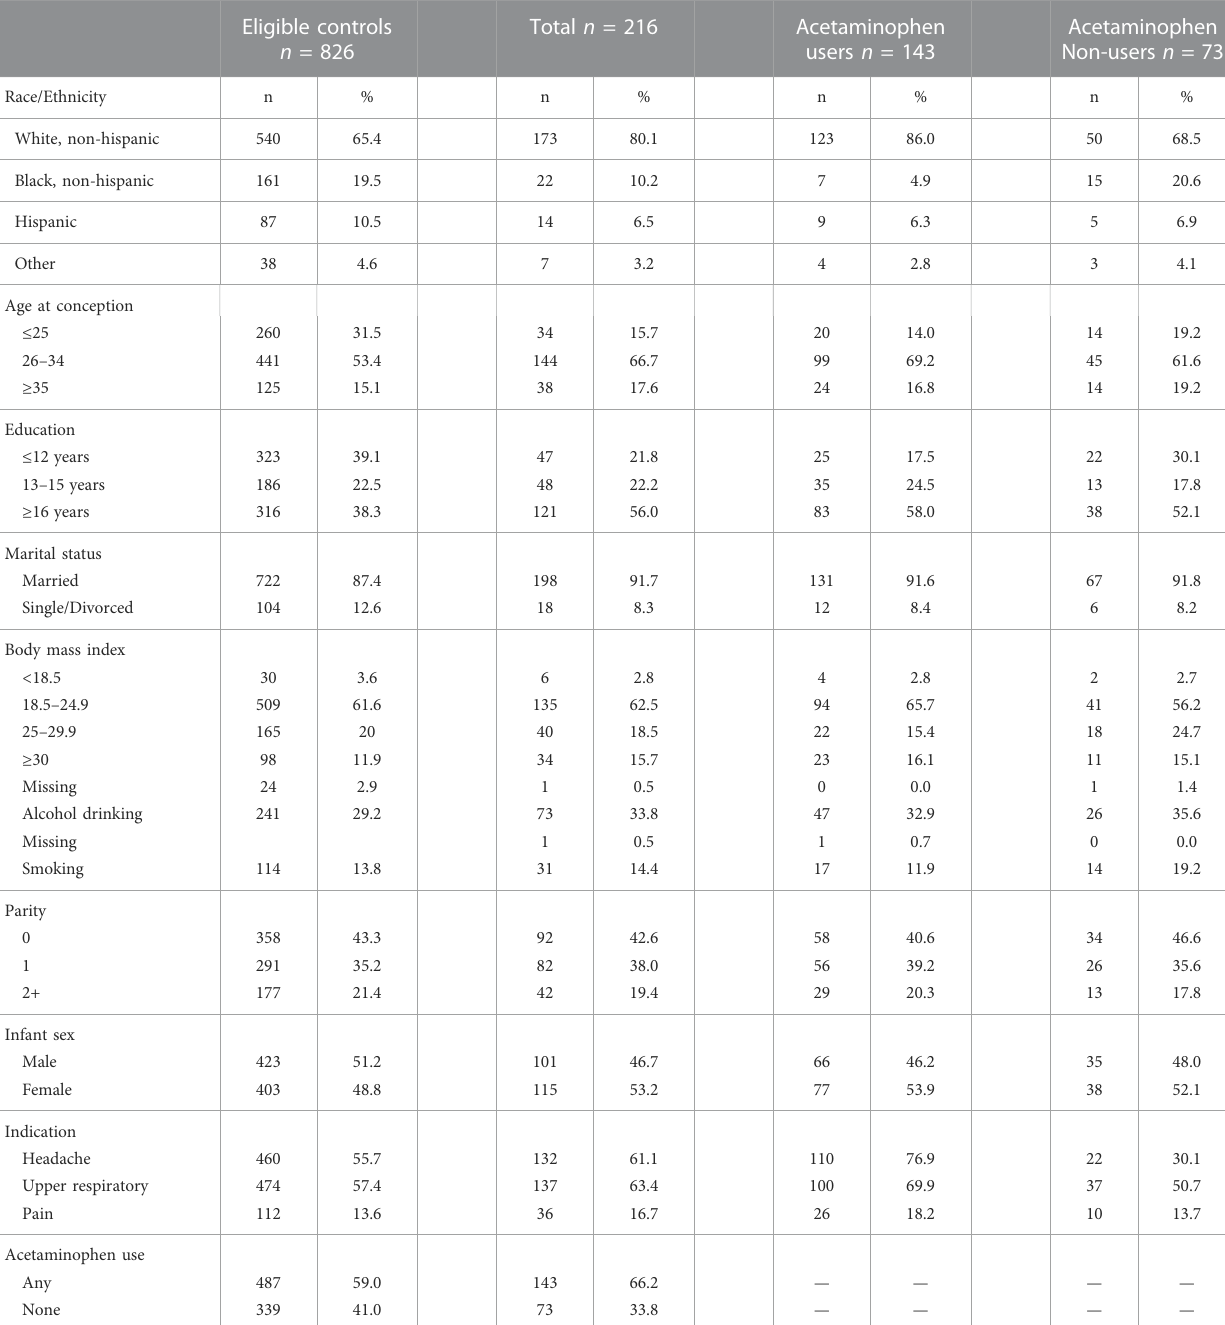
TABLE 1 Characteristics of eligible controls, participants at childhood and adolescent behavioral assessment, and by acetaminophen use during